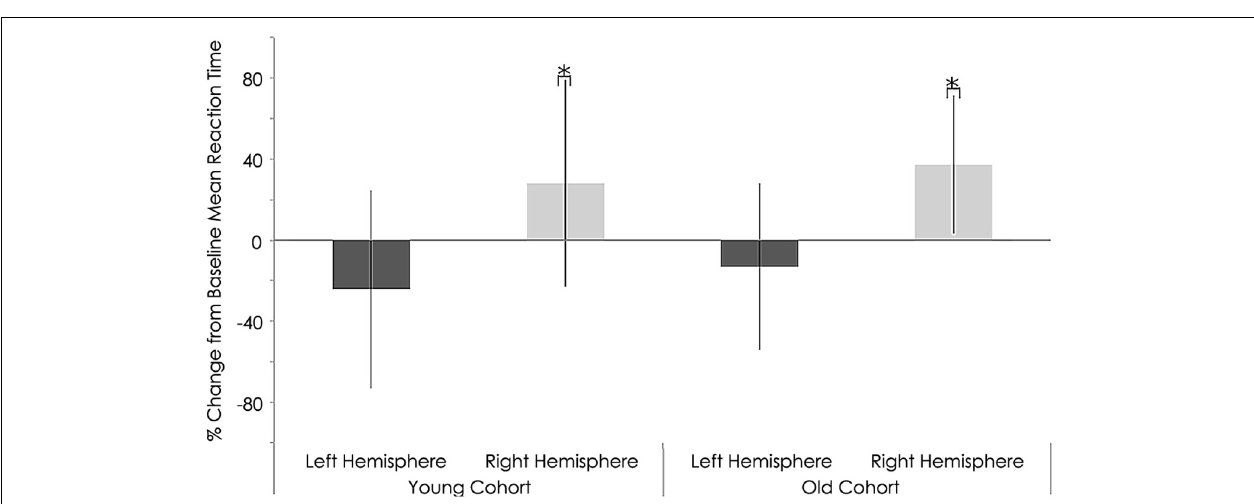
FIGURE 10 | Behavioral characteristics of the study sample before rTMS for reaction time (ms) task. Statistically significant differences in reaction time between right